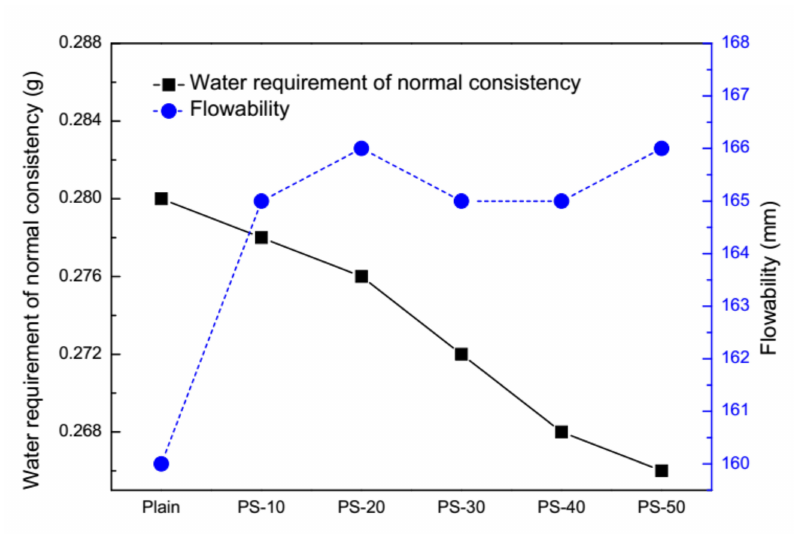
Figure 4. E ff ects of phosphorus slag on water requirement of normal consistency and